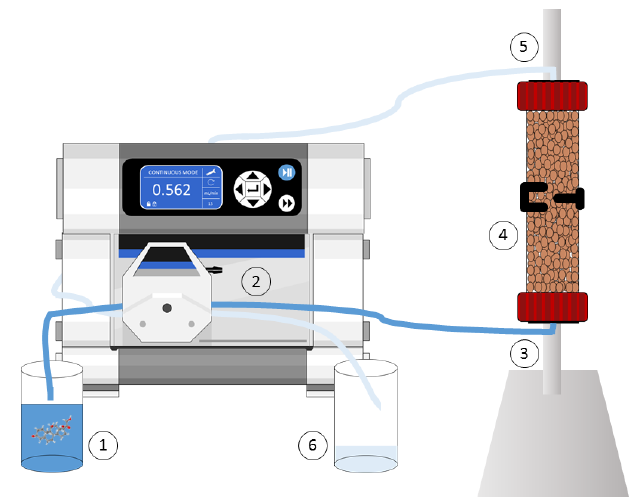
Figure 3. Schematic diagram of the flow system: (1) contaminated initial solution, (2) peristaltic pump, (3) input of the column, (4) column, (5) output of the column, (6) treated final solution.